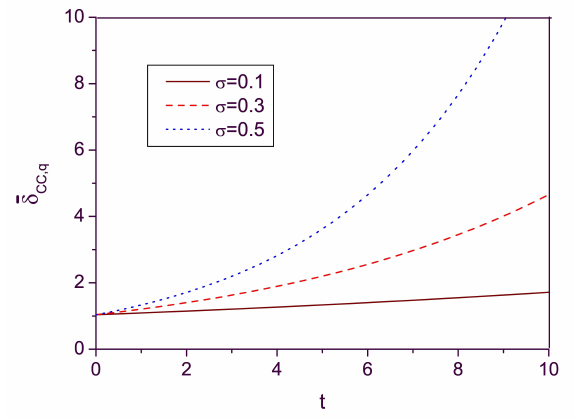
Figure 4: Time evolution of the MDACC in p -space given in Eq. (18), for three different values of σ . We used (cid:126) = 1 , ω = 1 , (cid:15) = 1 , and β = 1